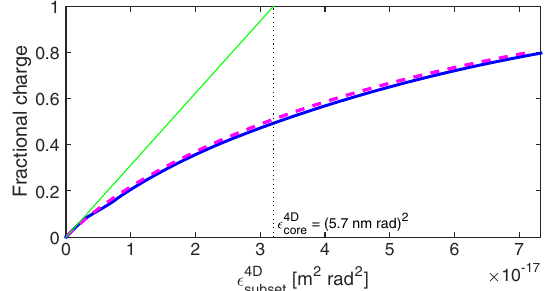
FIG. 5. Solid blue line represents the fractional emittance of the particle distribution comprised in different fractions of the beam, obtained from the reconstruction of the 4D trace space density of the simulation in Fig. 1. The solid green line shows the tangent line to the reconstructed curve at the core to linearly extrapolate the core emittance. The dashed pink line is the analytical curve of a 4D Gaussian distribution with the same rms emittance.